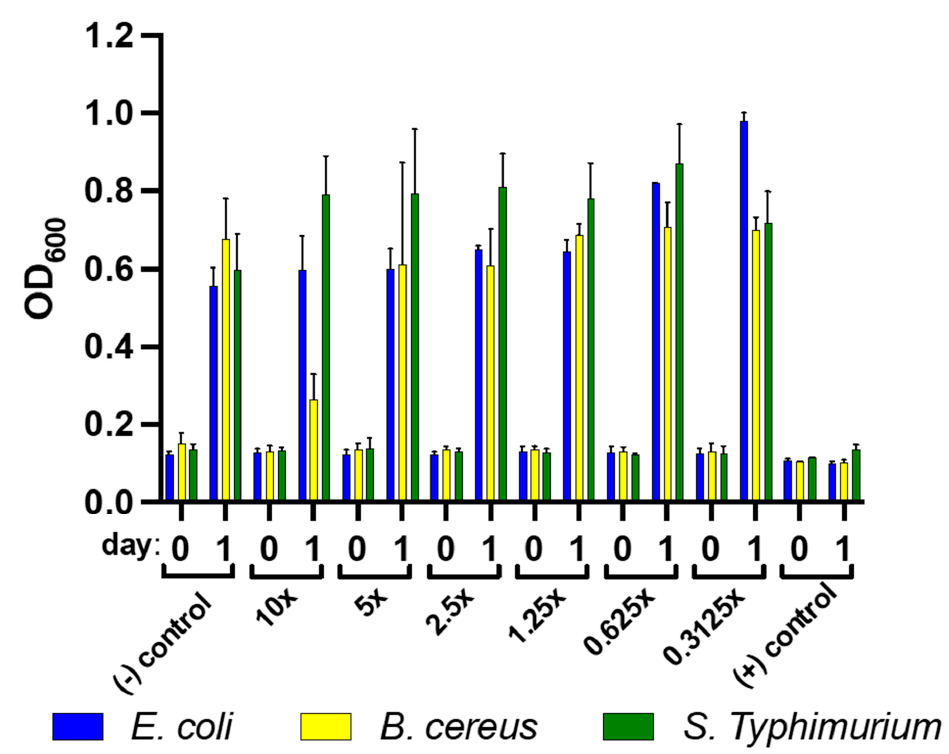
Figure 5. Antimicrobial properties of watermelon rind extract in 96-well plates at concentrations from 10–0.3125% against B. cereus , E. coli , and S. enterica subsp. enterica serovar Typhimurium when incubated at 37 °C for 24 h. The growth was monitored at OD6 00 using a microplate reader spectrophotometer. The error bars indicate the standard deviation (n = 3).